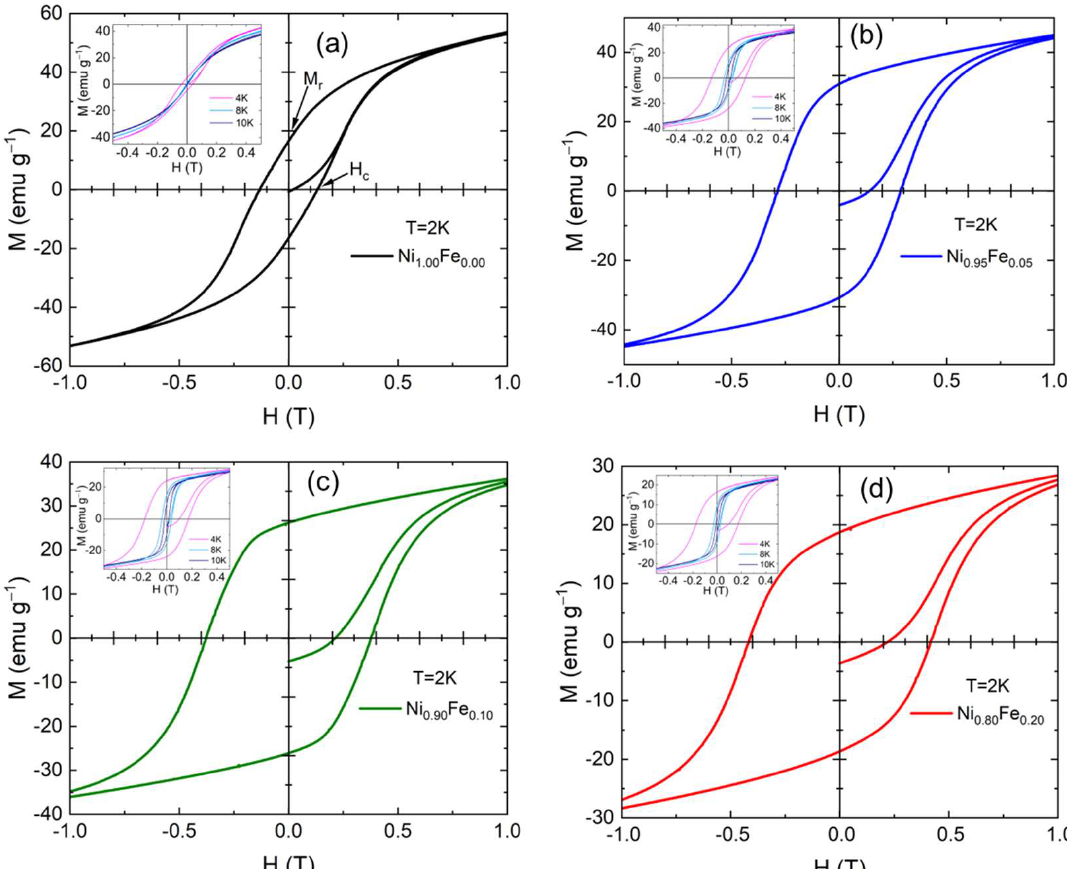
Figure 9. M vs. H loops at 2 K for ( a ) Ni 1.00 Fe 0.00 (0% Fe), ( b ) Ni 0.95 Fe 0.05 (5% Fe), ( c ) Ni 0.90 Fe 0.10 (10% Fe), and ( d ) Ni 0.80 Fe 0.20 (20% Fe) The remanence (M r ) and coercivity (H c ) are labeled in ( a ); insets in ( a – d ) show M vs. H loops for 4, 8 and 10 K.